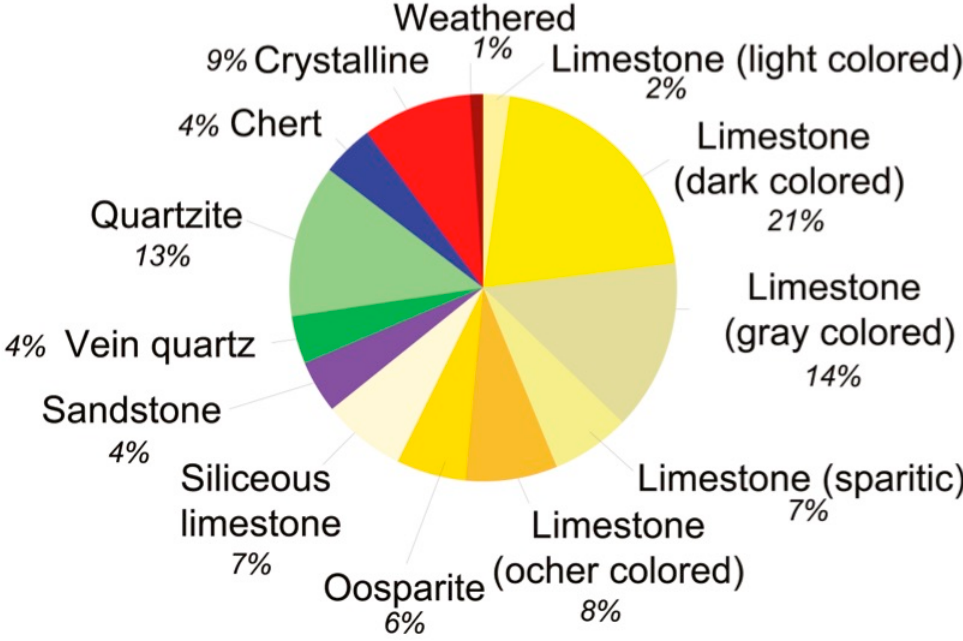
Figure 5. Clast petrography of the Bünten Till analyzed at the Möhlin site.